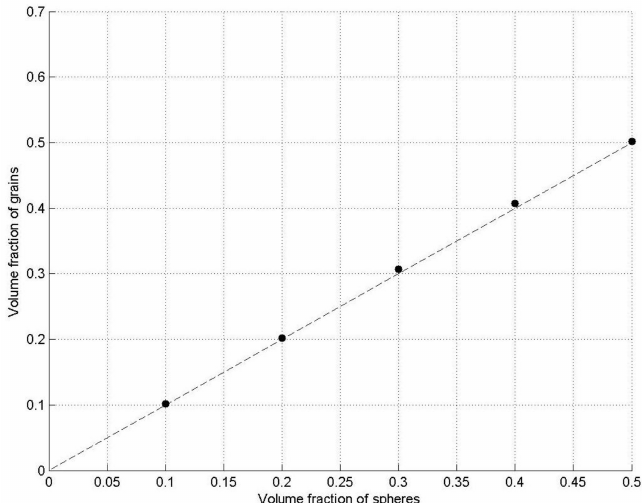
Figure 3. The relations of volume fraction between ferrite phase grains and corresponding spheres (the reference line represents the relations when these two volume fractions are